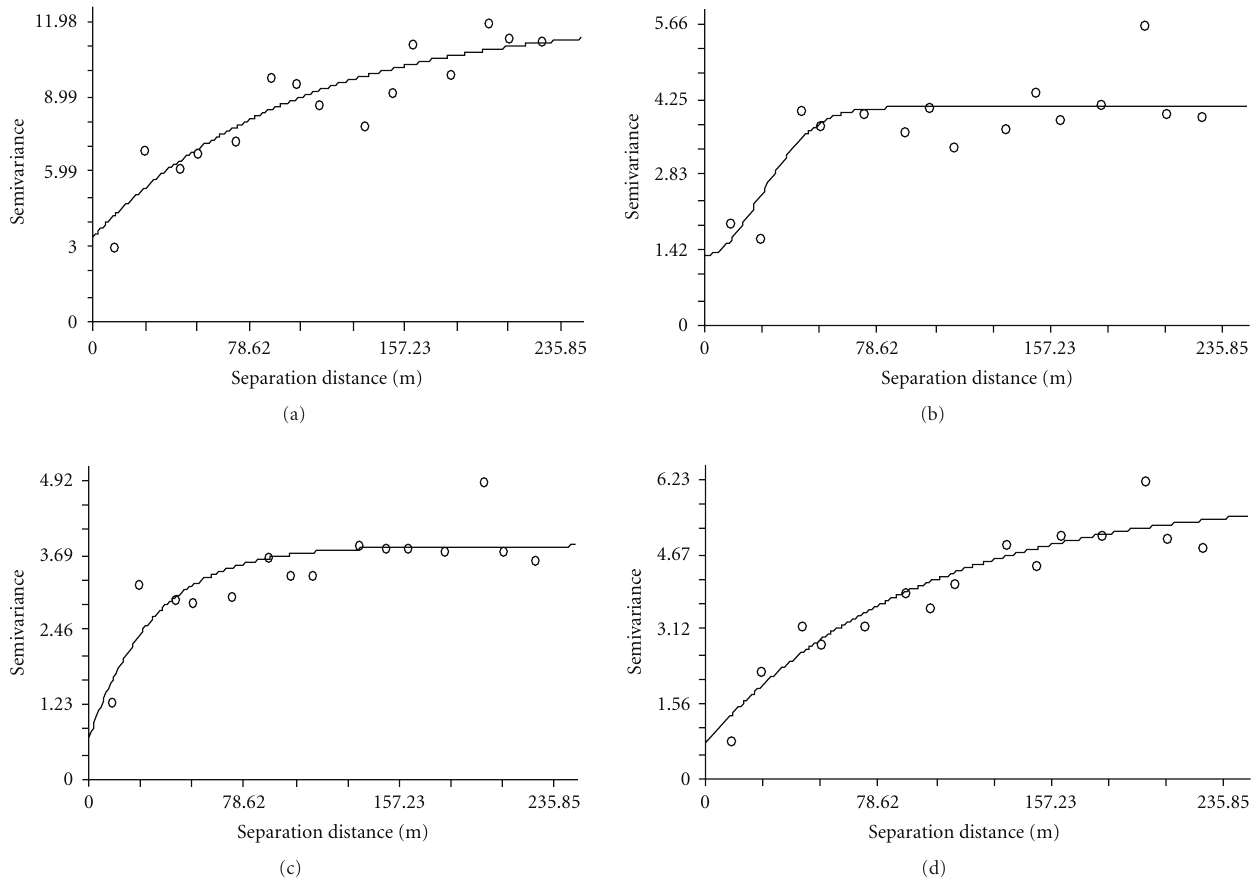
Figure 5: Best fitted model (solid lines) and experimental variogram (symbols) of EC. (a) Exponential model at 0–20 cm depth during 2009. (b) Gaussian model at 20–40 cm depth during 2009. (c) Exponential model 0–20 cm depth during 2010. (d) Exponential model at 20–40 cm depth during